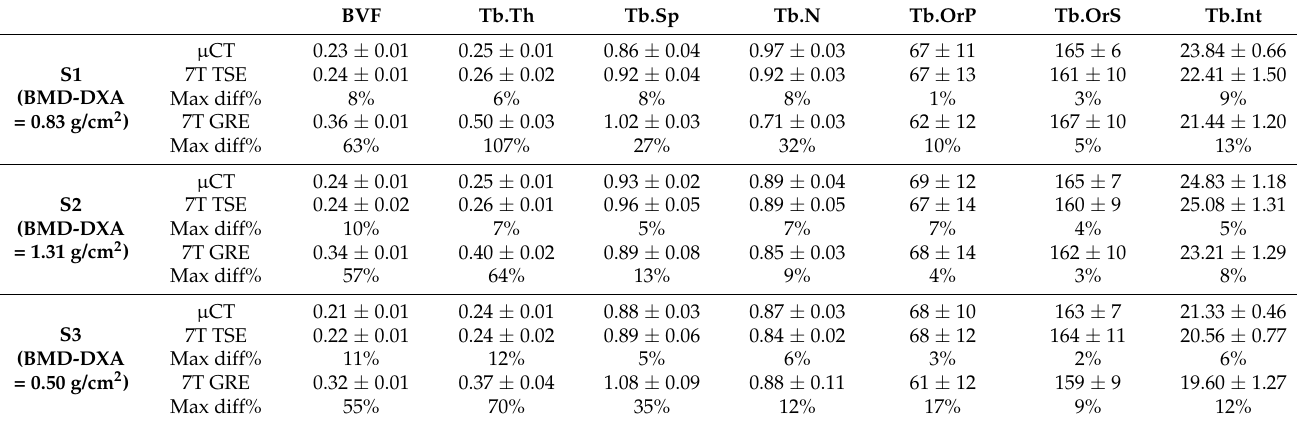
Table 3. Morphological characteristics between registered µ CT—7T MR images. BVF Tb.Th Tb.Sp